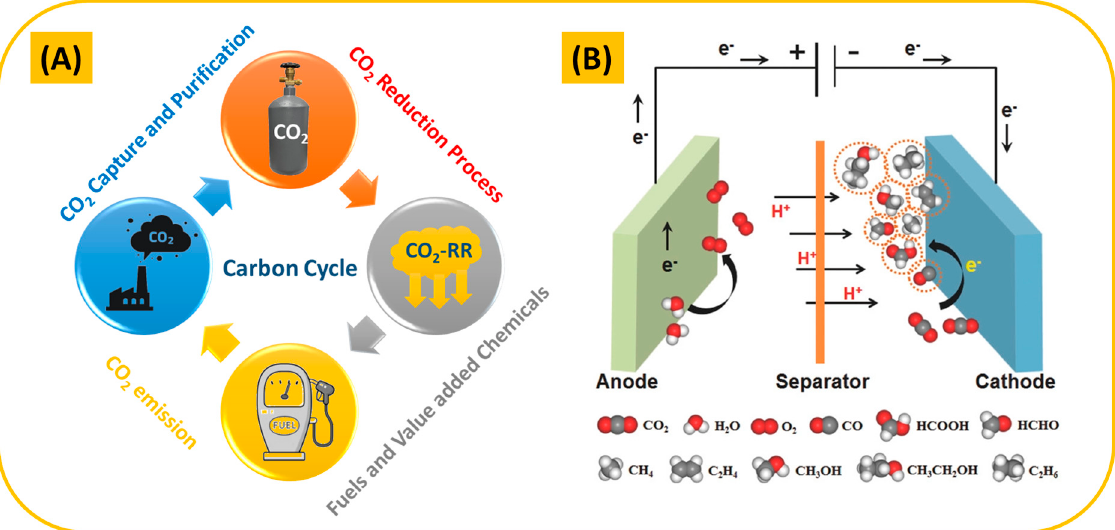
Figure 1. Depiction of the simplified overall anthropogenic carbon cycle ( A ) and electrochemical CO 2 reduction reaction in an electrochemical cell with possible carbon products ( B ) [6] (copyright: John Wiley and Sons, 2017).